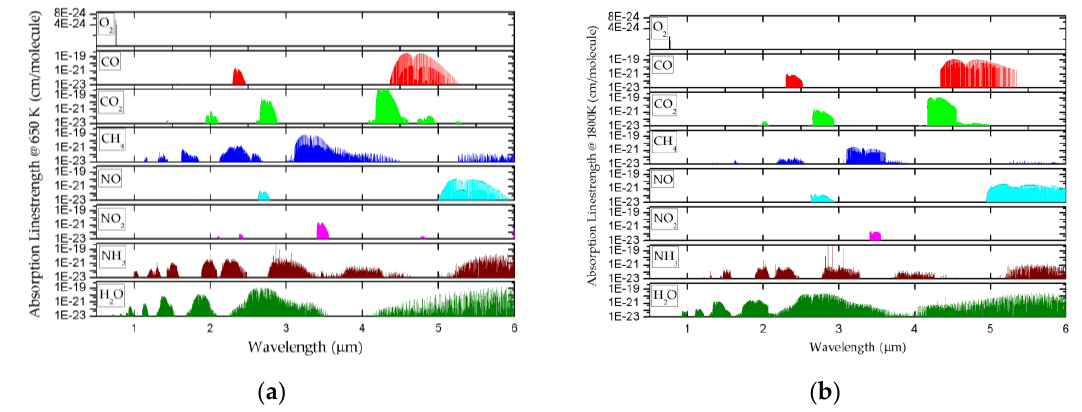
Figure 3. Absorption linestrengths for O 2 , CO, CO 2 , CH 4 , NO, NO 2 , NH 3 , and H 2 O at ( a ) 650 K, ( b ) 1800 K. Transitions with line strengths less than 1 × 10 − 23 cm / molecule are not shown. All data taken from HITRAN2016 [47].